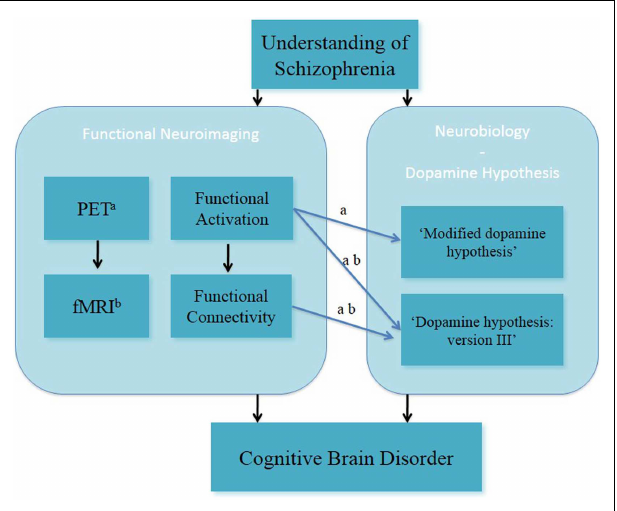
FIGURE 1 | Understanding of schizophrenia as a cognitive brain disorder – verbal/numeric “N-back” task . a fMRI; b PET, positron emission